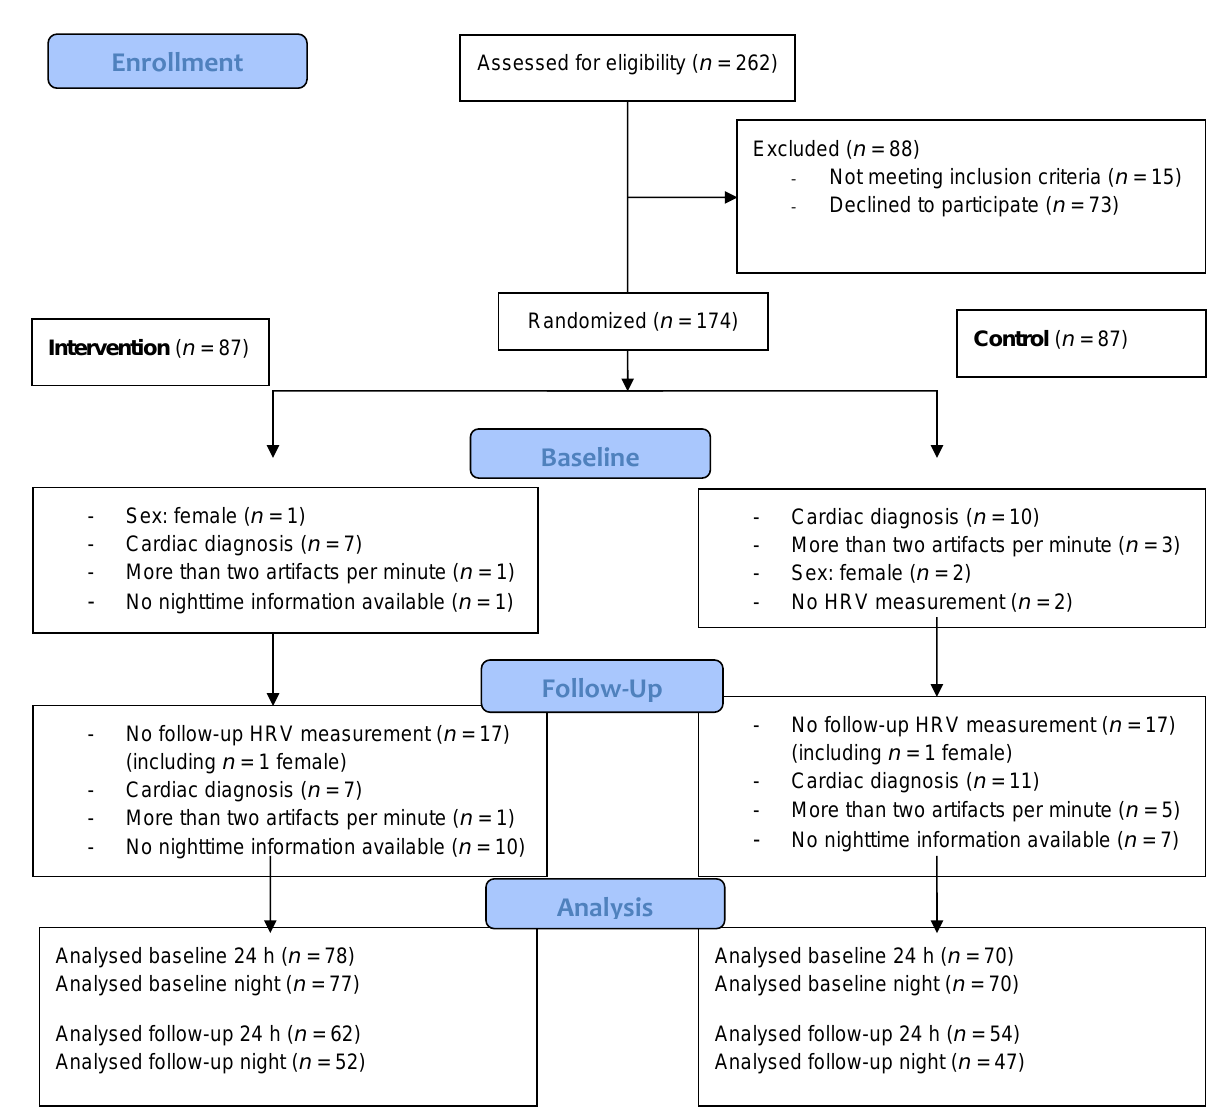
Figure 1. The recruitment